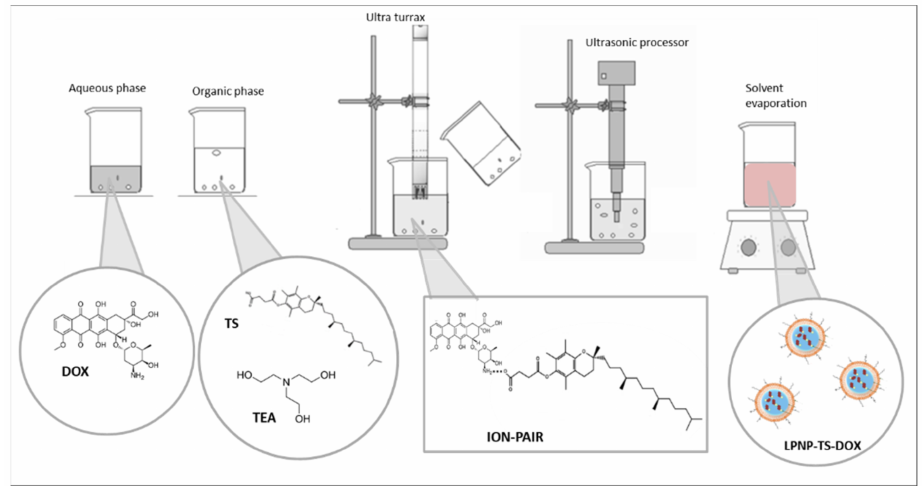
Figure 1. Schematic representation of LPNP-TS-DOX preparation method and formation in situ of the ion pair between DOX and